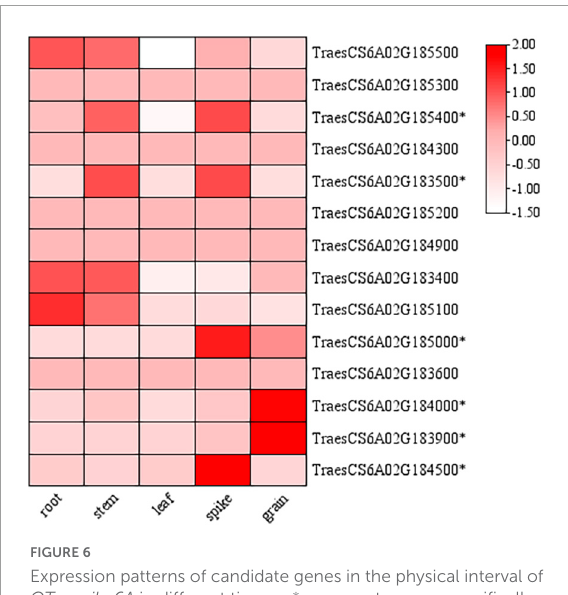
FIGURE6 Expression patterns of candidate genes in the physical interval of QTgw.cib-6A in different tissues. ∗ represents genes specifically expressed in the spike and grain; the data of expression profiles were obtained from the public online database